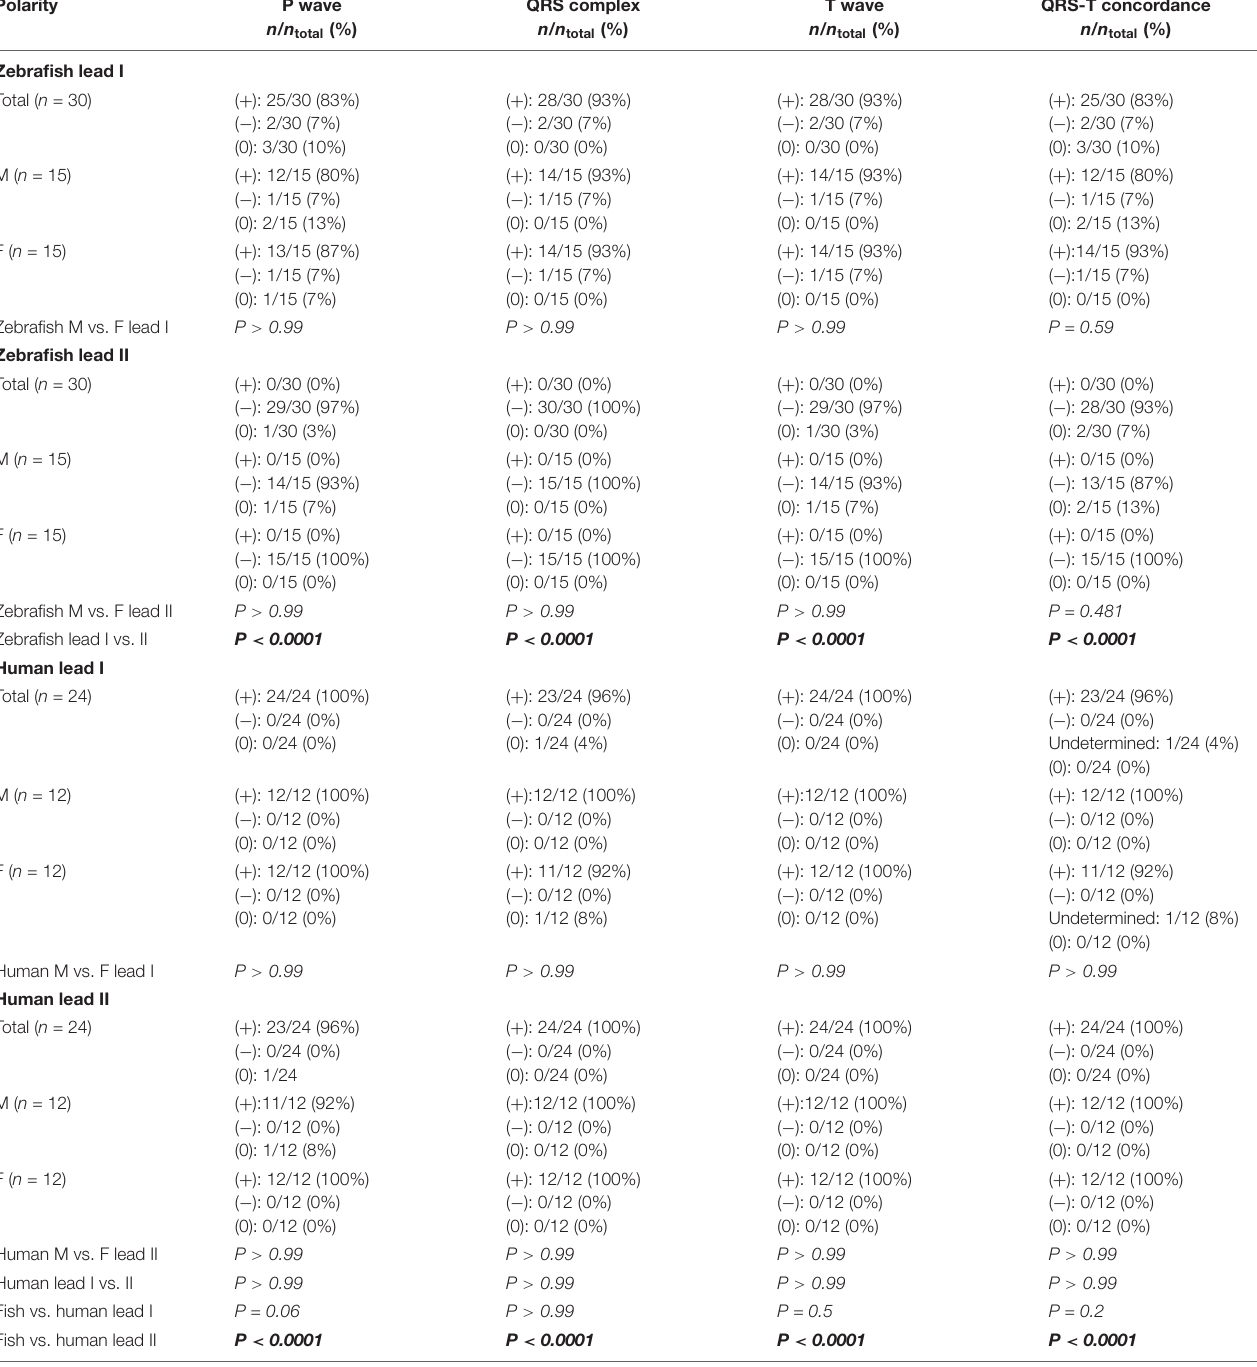
TABLE 3 | Polarity of ECG components on Einthoven leads in zebrafish vs. humans. Polarity P wave